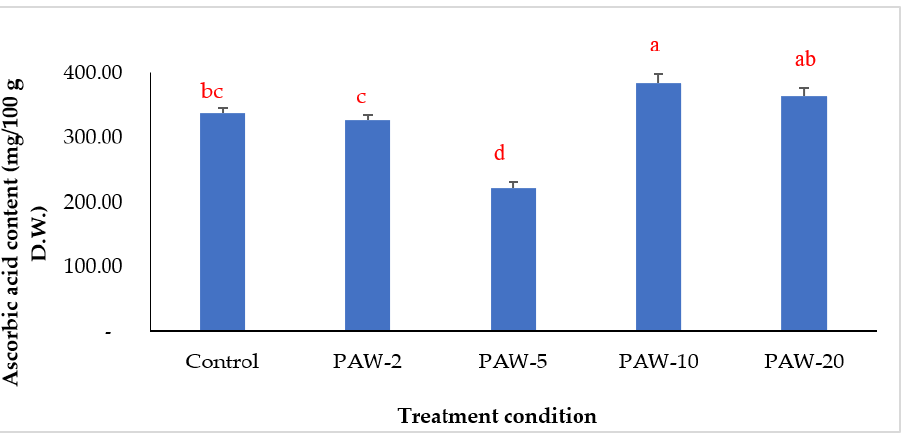
Figure 2. Changes in ascorbic acid content of PAW treated rocket samples at different treating times compared to control samples. Means that do not share letters differ significantly ( p < 0.05) according to Tukey’s test. Legends: PAW-2, PAW-5, PAW-10, and PAW-20 refer to rocket samples subjected to plasma-activated water (PAW) treatment for 2, 5, 10, and 20 min, respectively.